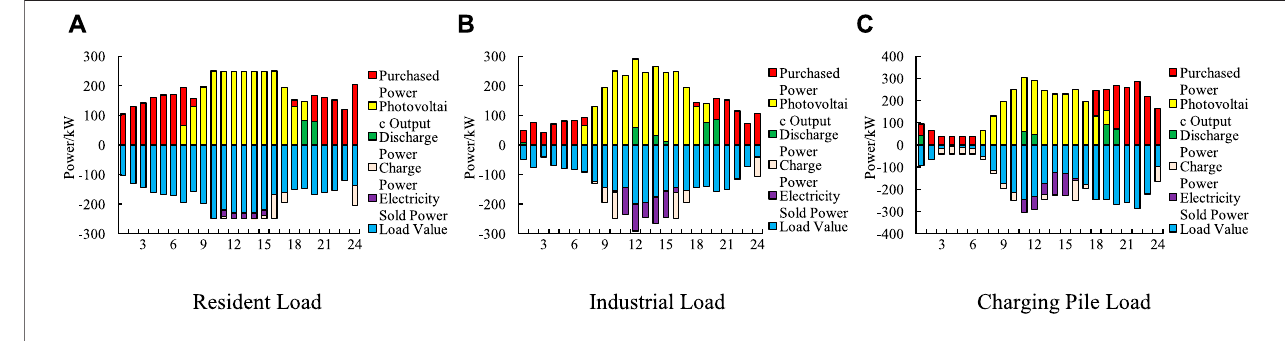
FIGURE 5 | Optimal scheduling outputs of units in Mode 2.